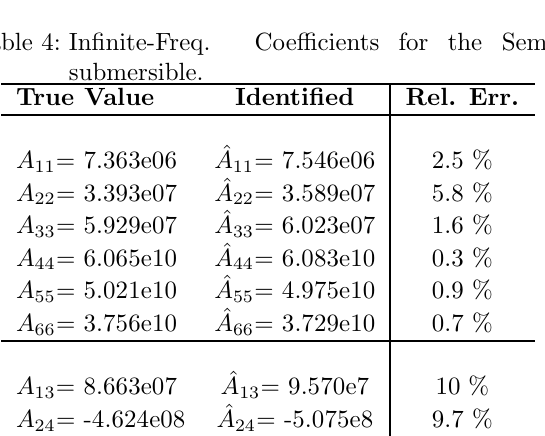
Table 4: Infinite-Freq. Coefficients for the Semi- submersible. True Value